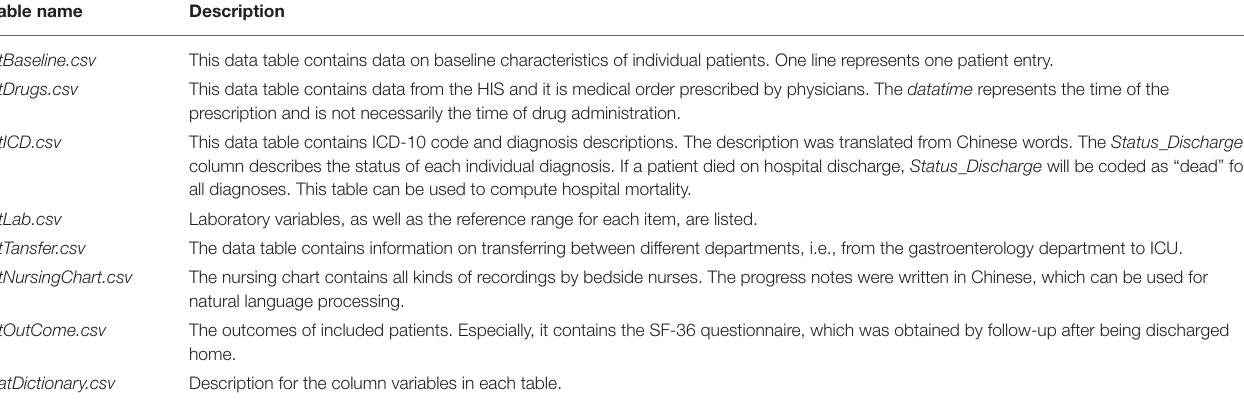
TABLE 1 | Overview of the data tables in the critical care